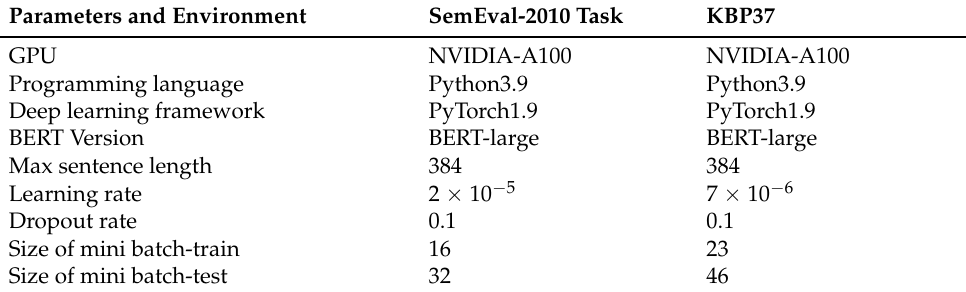
Table 5. Experimental parameters and experimental